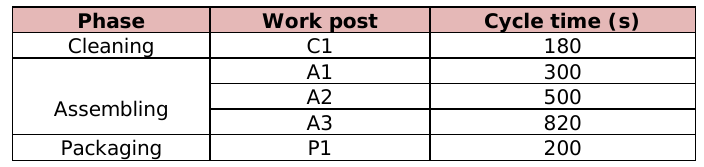
Table 2. “Description of the production process (initial